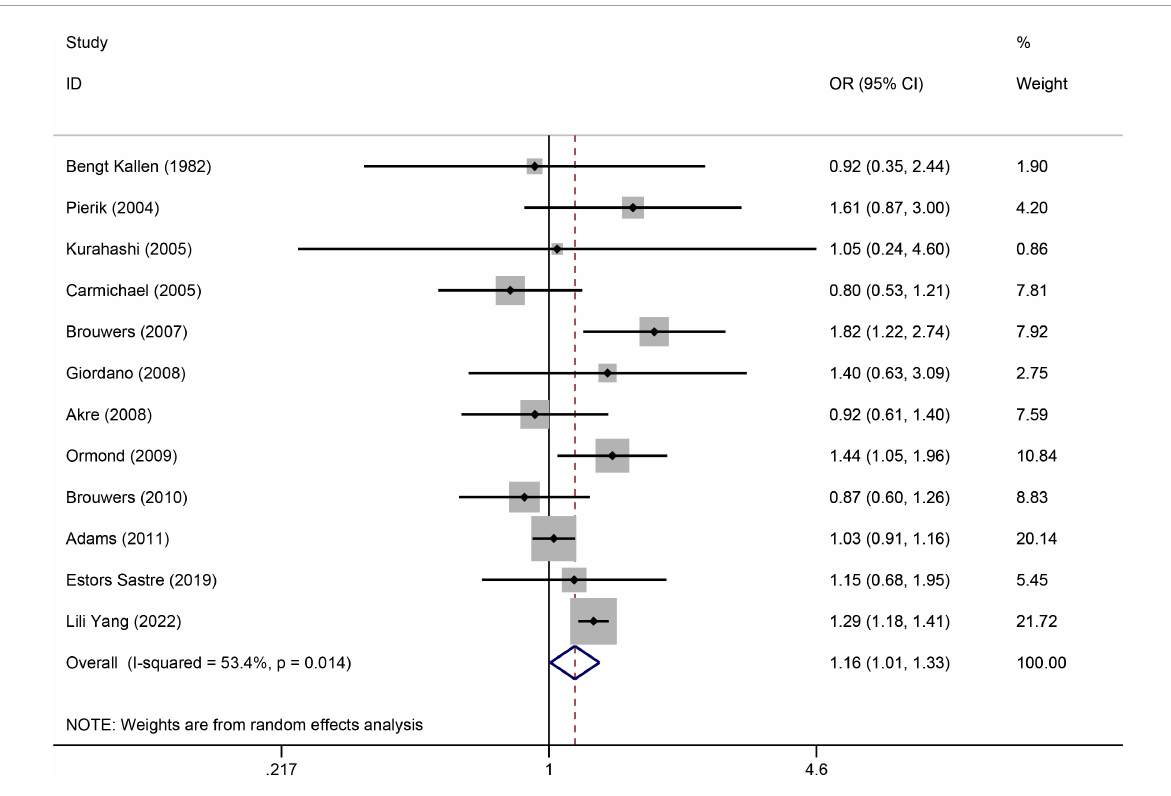
FIGURE4 Forest plot for the relationship between maternal smoking during pregnancy and the risk of hypospadias. Studies were sorted by the sequence of publication